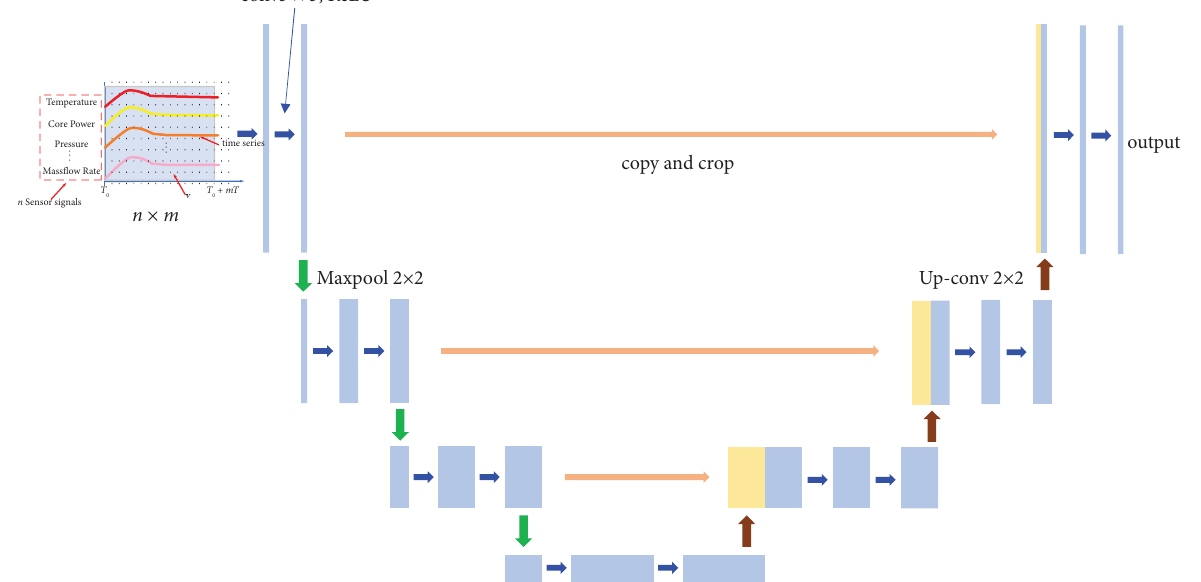
Figure 3: Architecture of state prediction network.